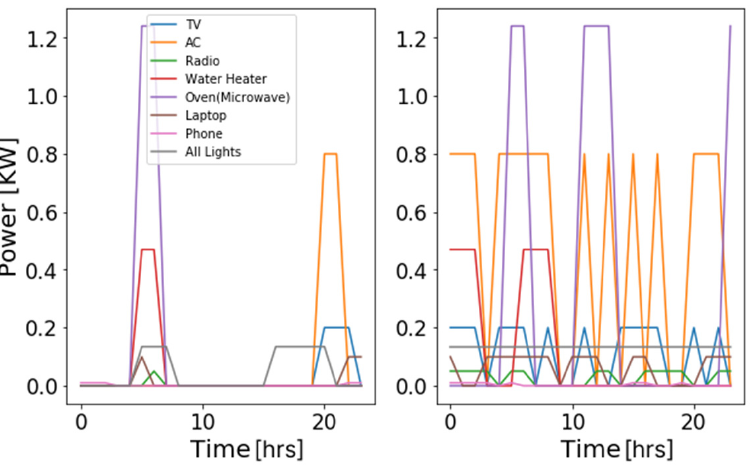
Figure 9. Power usage by each device with the proposed SV load allocations (left side) vs. real usage according to the REDD (right side) [31] database.